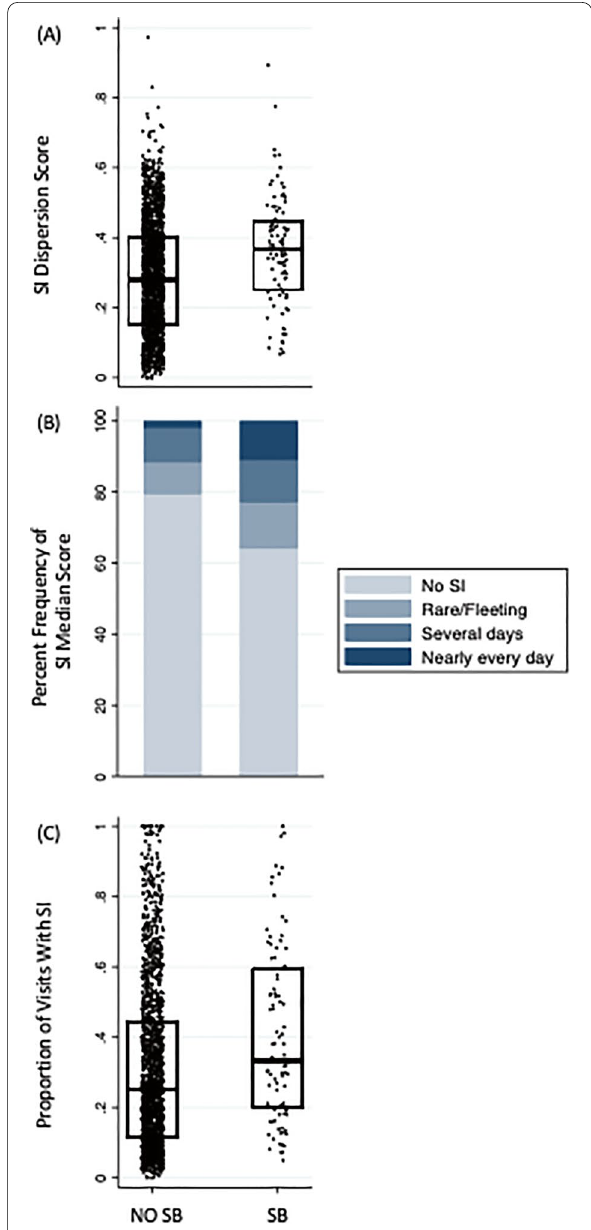
Fig. 1 Distribution of suicidal ideation (SI) variability, intensity, and persistence by outcome group [suicidal behavior (SB) versus no suicidal behavior (No SB)]. A SI variability: box plot with interquartile range of SI dispersion score; B SI intensity: percent frequency of SI median score (no SI, rare/fleeting, several days, nearly every day); C SI persistence: box plot with interquartile range of proportion of visits with